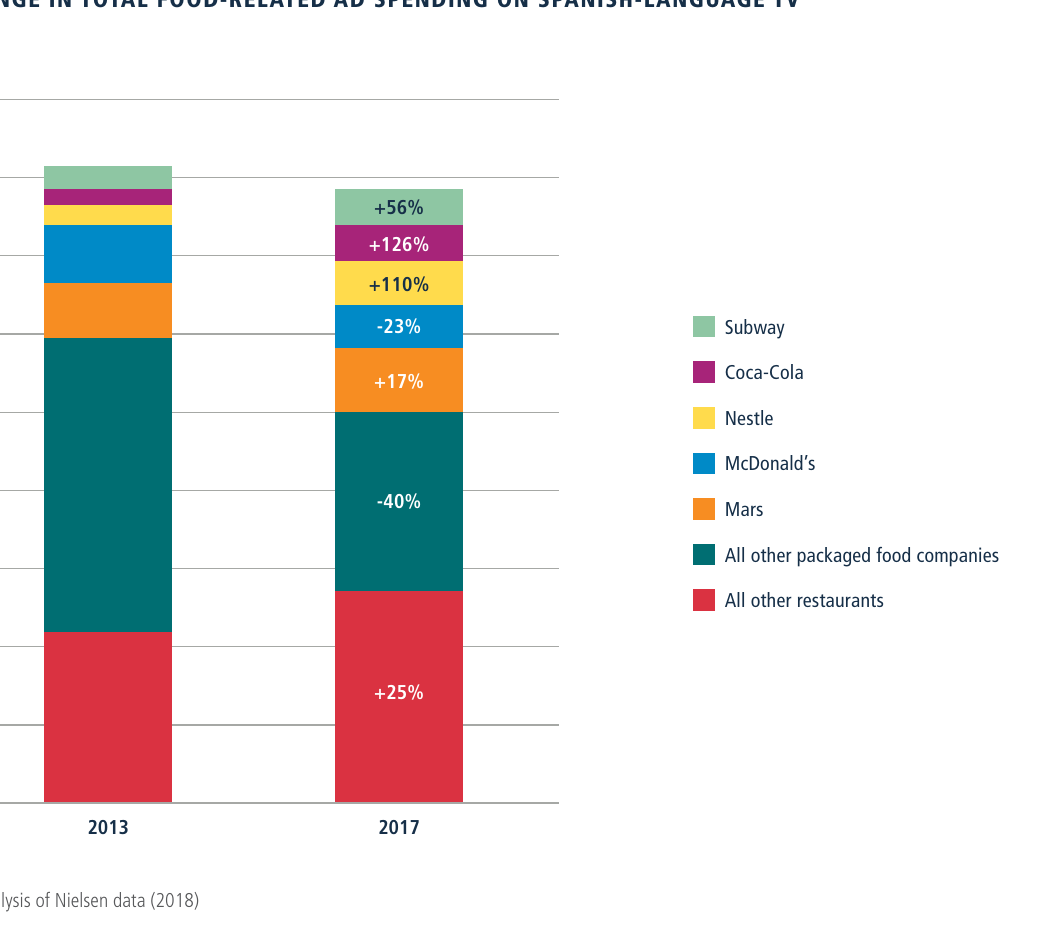
FIGURE 5. CHANGE IN TOTAL FOOD-RELATED AD SPENDING ON SPANISH-LANGUAGE TV